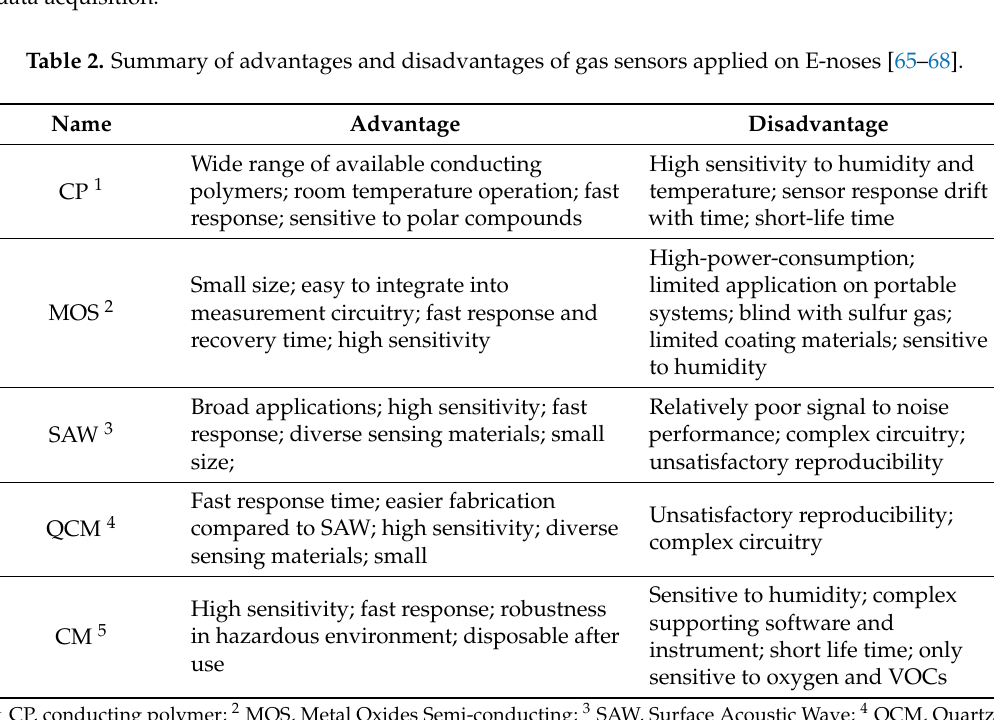
Figure 1. An E-nose system based on QCM sensor array. MFC, mass flow control; DAQ, data Figure acquisition.